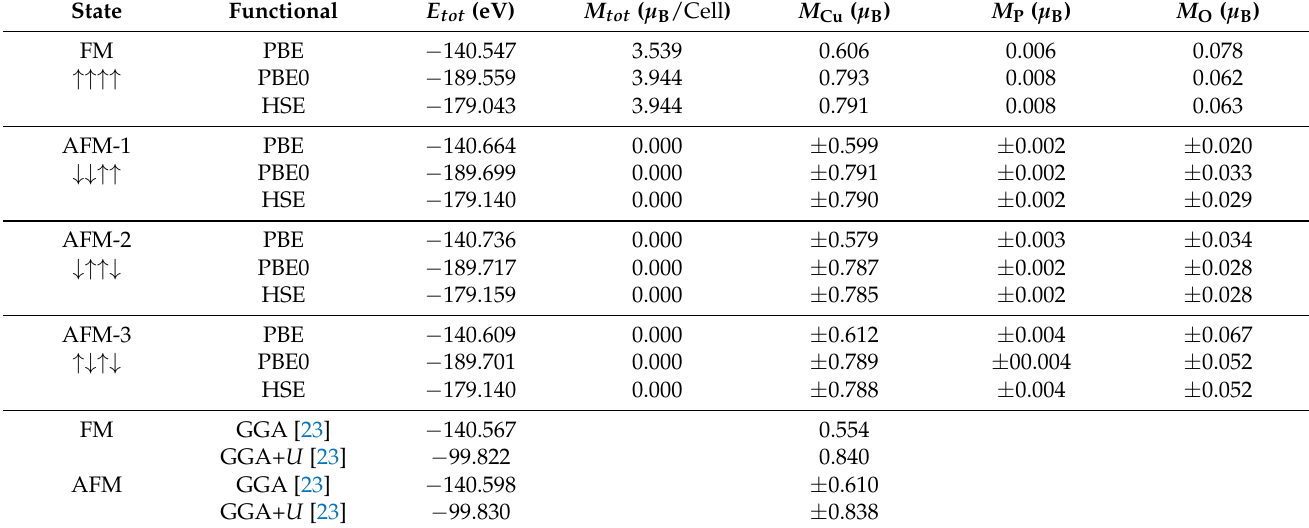
Table 4. Calculated total energy E tot (eV per primitive cell), total magnetic moment M tot (Bohr magnetons µ B per primitive cell), and local magnetic moments M Cu , M P , and M O ( µ B ) on the respective atoms in α -Cu 2 P 2 O 7 . Previous theoretical data are also quoted for comparison